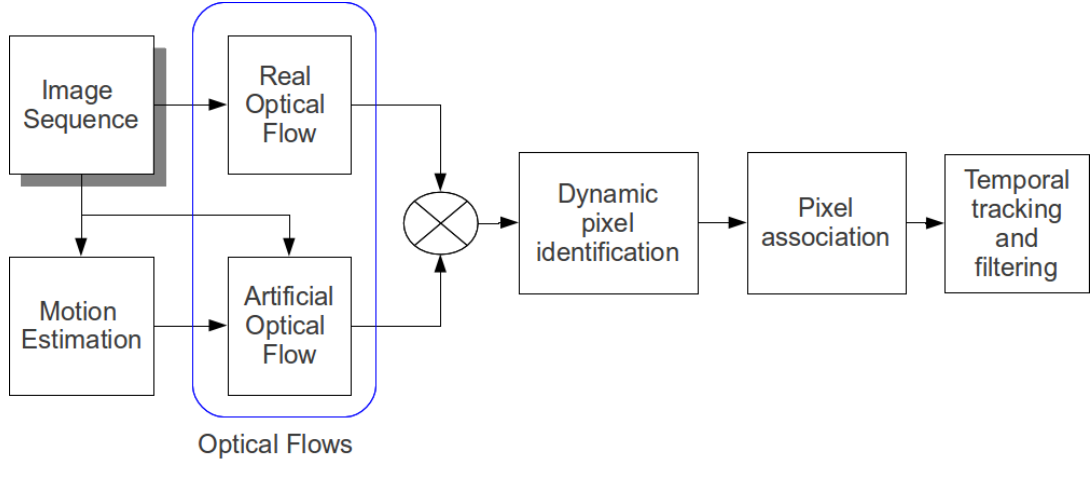
Figure 1. Workflow of the dynamic object identification and tracking process. Based on an image sequence the algorithm provides a list of dynamic objects with several associated characteristics such as position, size, velocity and color. Additional sensors could also provide other parameters, such as the